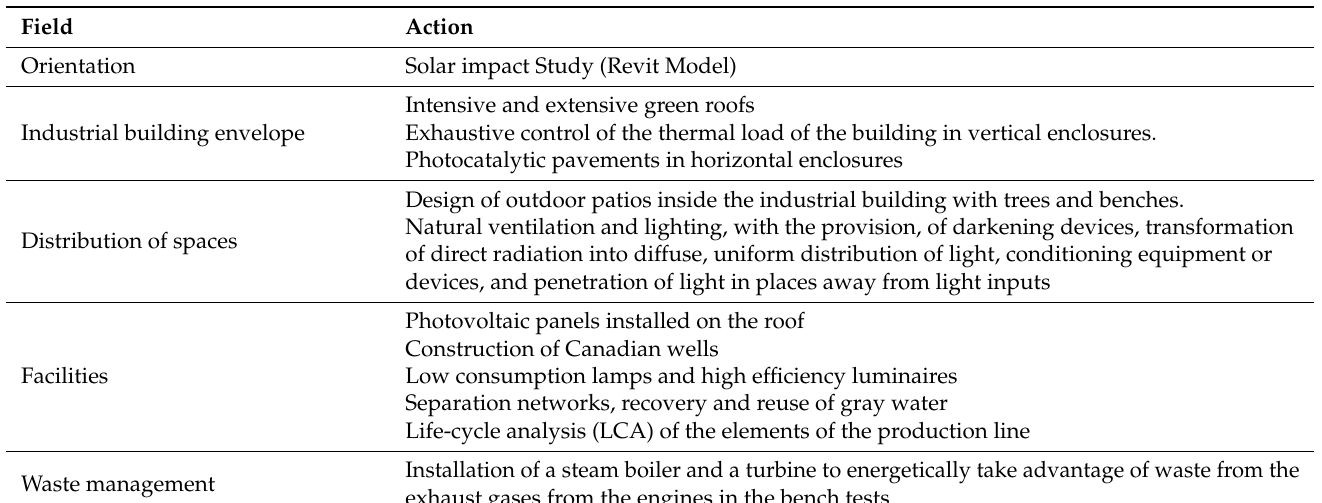
Figure 4. Academic proposal, industrial building, and process: ( a ) Exterior of industrial building ( b ); interior of the administrative area; ( c ) interior of the industrial area; ( d ) work cell. Table 9. Sustainability strategies: academic